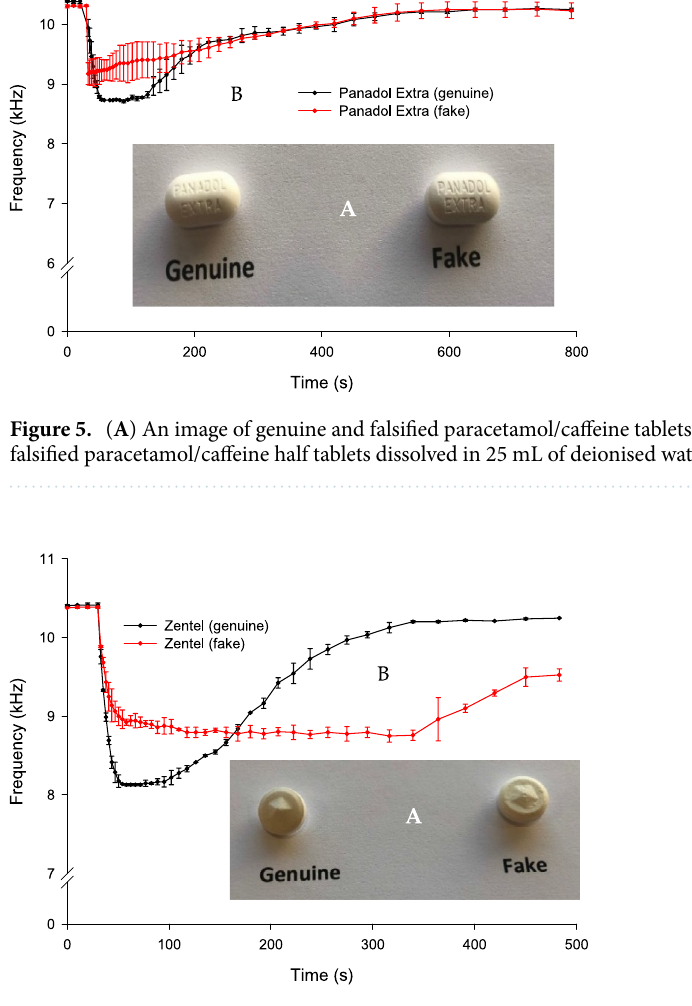
Figure 6. ( A ) An image of genuine and falsified albendazole tablets. ( B ) BARDS data of genuine and falsified half tablets of albendazole dissolved in 25 mL of deionised